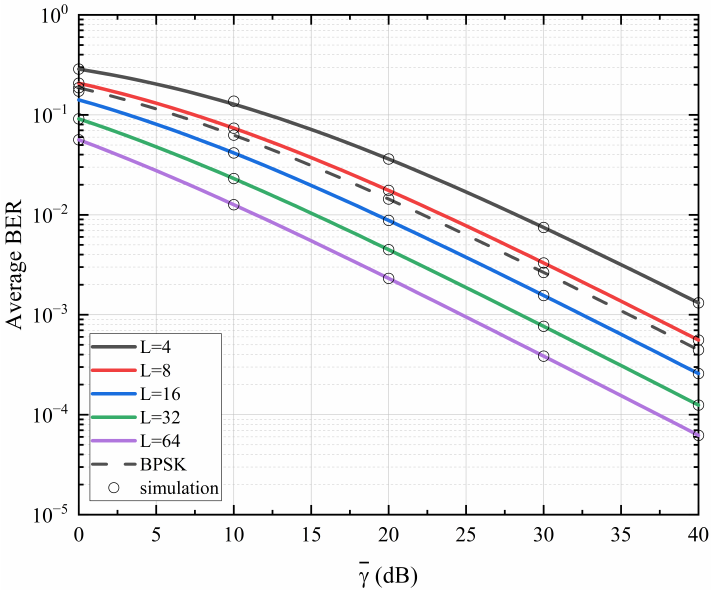
Figure 6. Average BER of end-to-end downlink under different L when α = 4.0, β = 1.6, ξ = 10, d = 5.0 km, N =